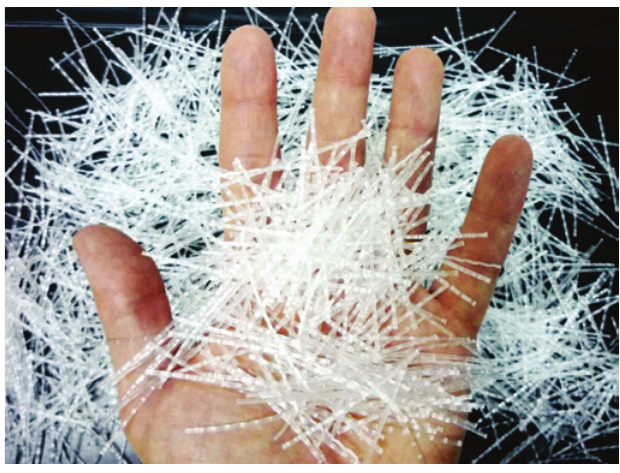
Polypropylene macro-fibers